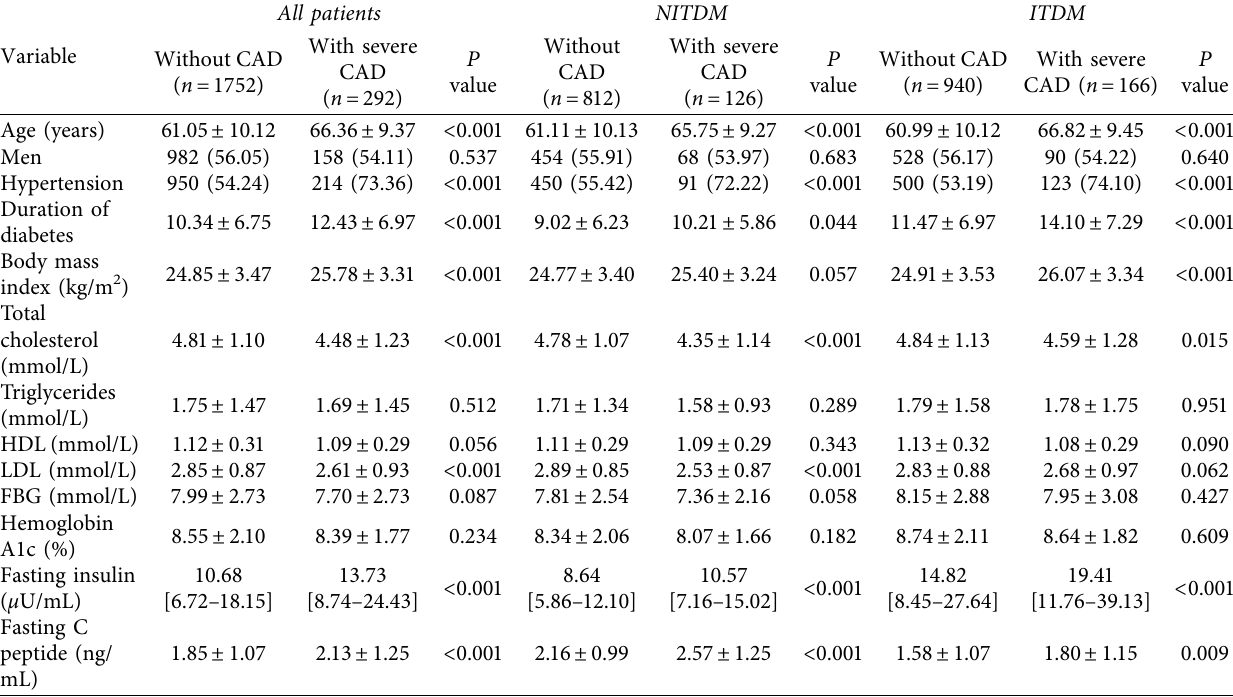
Table 1: Clinical characteristics of patients with T2DM with severe CAD and without CAD.